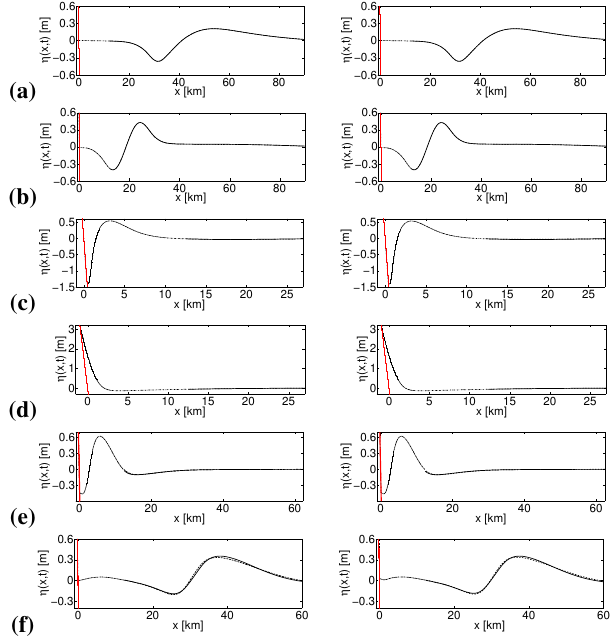
Fig. 16. Free-surface profiles of Aceh simulations with the linear Figure 16. Free-surface profiles of Aceh simulations with the linear model (left: LSWE, right: LVBM) coupled to the NSWE are shown model (left: LSWE; right: LVBM) coupled to the NSWE are shown by the dashed and dotted-dashed lines and of simulations for a linear by the dashed and dotted-dashed lines, and for simulations for a lin- ear model with an EBC implementation, are shown by the solid line model with an EBC implementation are shown by the solid line at at times (a) t = 800s, (b) 1600s, (c) 2700s, (d) 3200s, (e) 4000s, times (a) t = 800 s , (b) 1600 s , (c) 2700 s , (d) 3200 s , (e) 4000 s , and (f) 5400s. The solid and dashed lines are on top of one (f) 5400 s . The solid and dashed lines are on top of another.